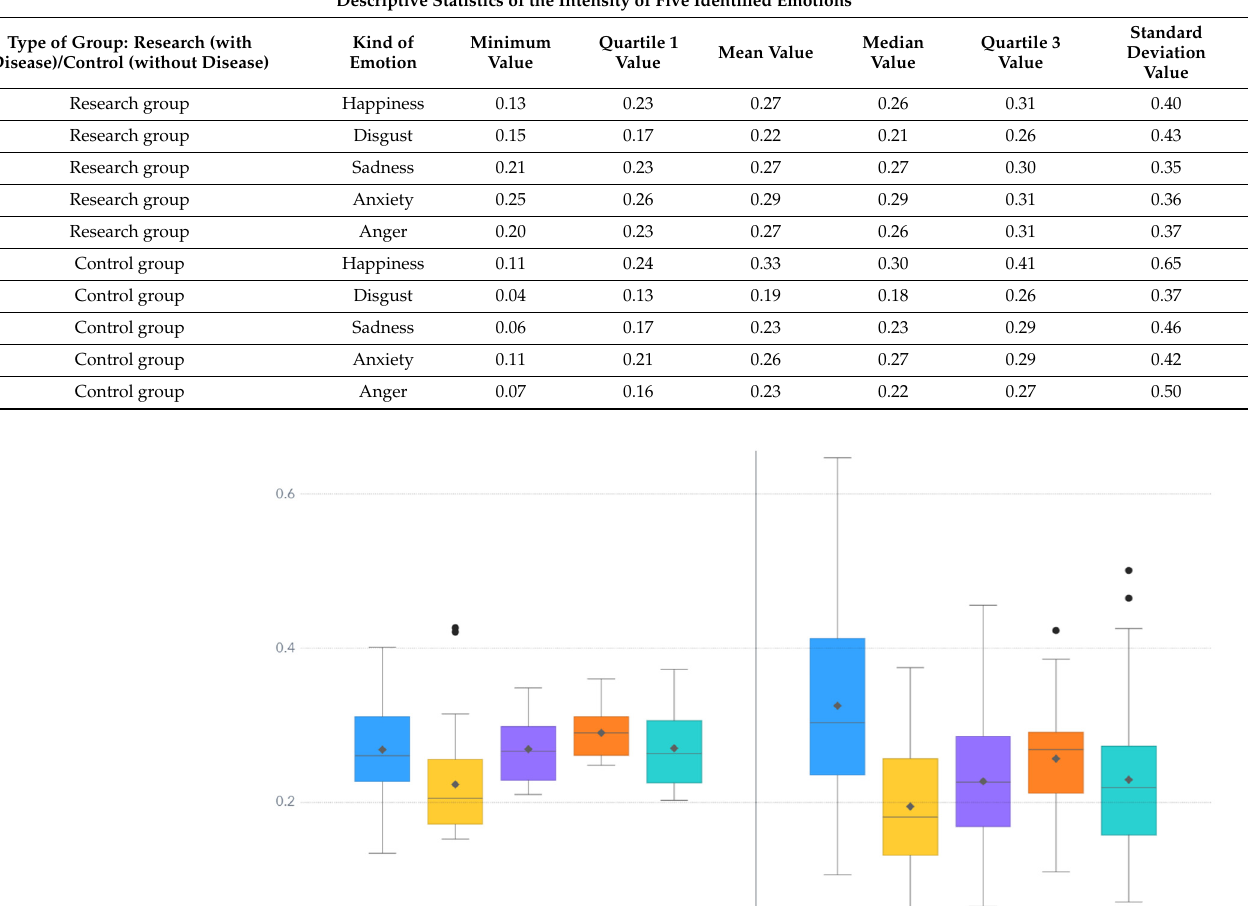
Table 1. Detailed table with data of distribution of emotions within research and control group.